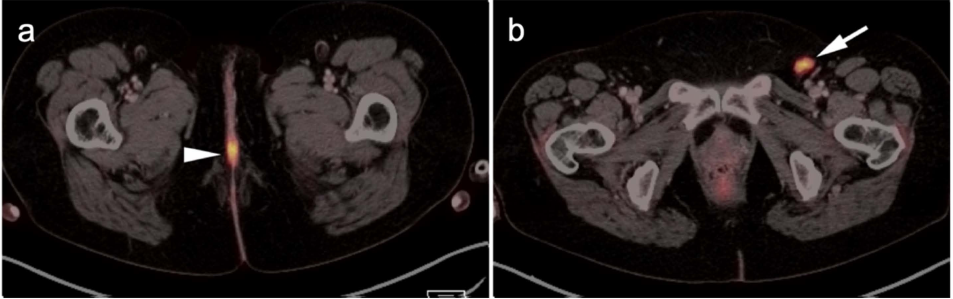
Figure 8. Vulvar melanoma. ( a ) Axial FDG PET-CT image of the pelvis shows a vulvar melanoma that is small but metabolically active (white arrowhead). ( b ) Axial FDG PET-CT of the pelvis also shows a hypermetabolic left inguinal node (white arrow), representing spread of disease.